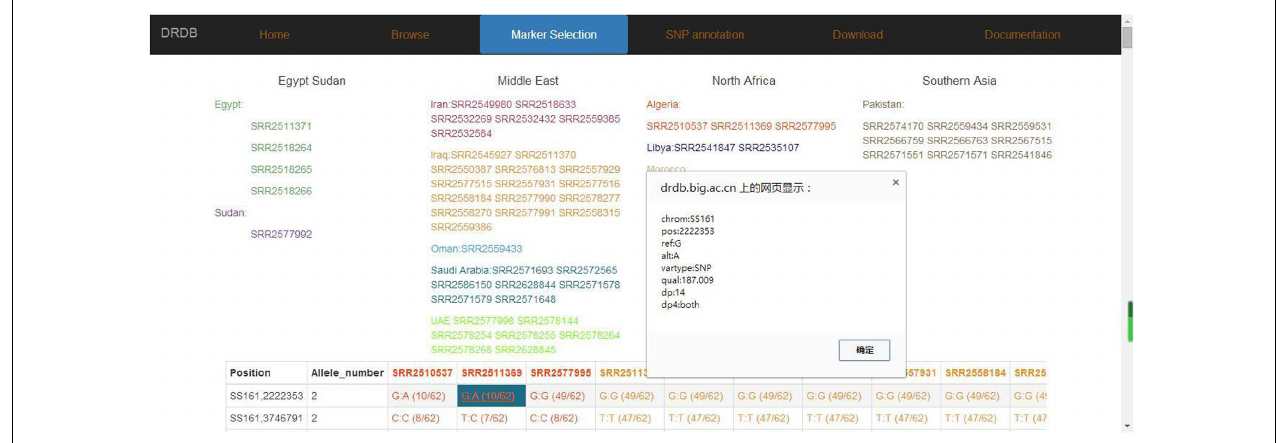
FIGURE 8 | Date palm genome database marker frequency page. Marker frequency and detail information are shown in this